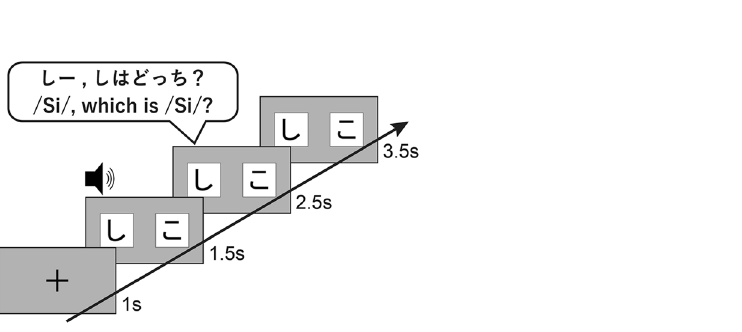
Table 1. Stimuli and letter properties in present study. Note that the reading rank is the correct response rate for each hiragana letter in 4- to 5-year-old preschoolers by the National Institute of Japanese Language (1972) 32 .